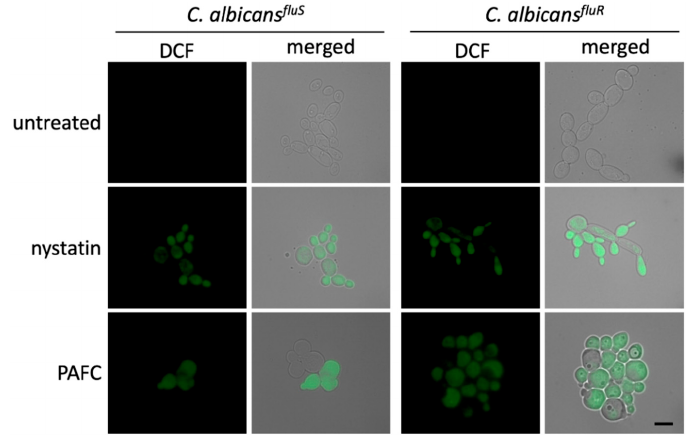
Figure 7. Induction of iROS by PAFC. Fluorescence microscopy of DCF-positive C. albicans fluS and C. albicans fluR cells to visualize iROS burden after exposure to 1 × IC 90 (2.5 μ M) PAFC for 8 h at 30 °C and continuous shaking at 160 rpm. The samples were washed in PBS before incubation for 30 min with H 2 DCFDA (5 ng µ L − 1 ). Excess of fluorescent dye was removed by washing in PBS and the cells were mounted on glass slides for evaluation of iROS induction by fluorescence microscopy. Cells without treatment and exposed to nystatin (10 µ g mL − 1 ) were used as negative and iROS-positive controls, respectively. The merged images show the DCF signal (green) superimposed with the Candida cells visualized with brightfield microscopy. One representative experiment out of three independent experiments is shown. Scale bar, 5 µ